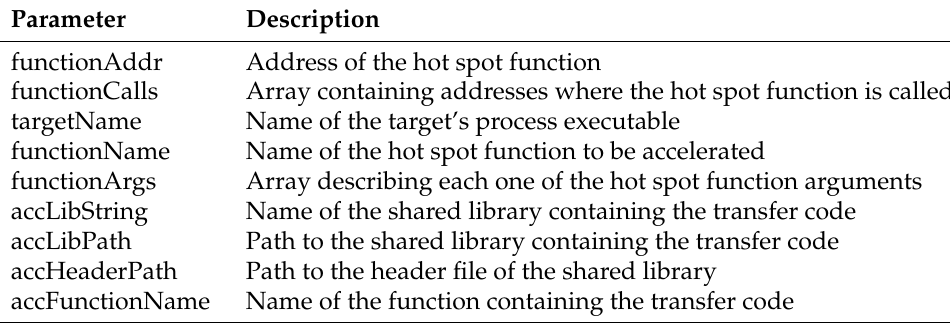
Table 1. Parameters in the JSON configuration file and the corresponding